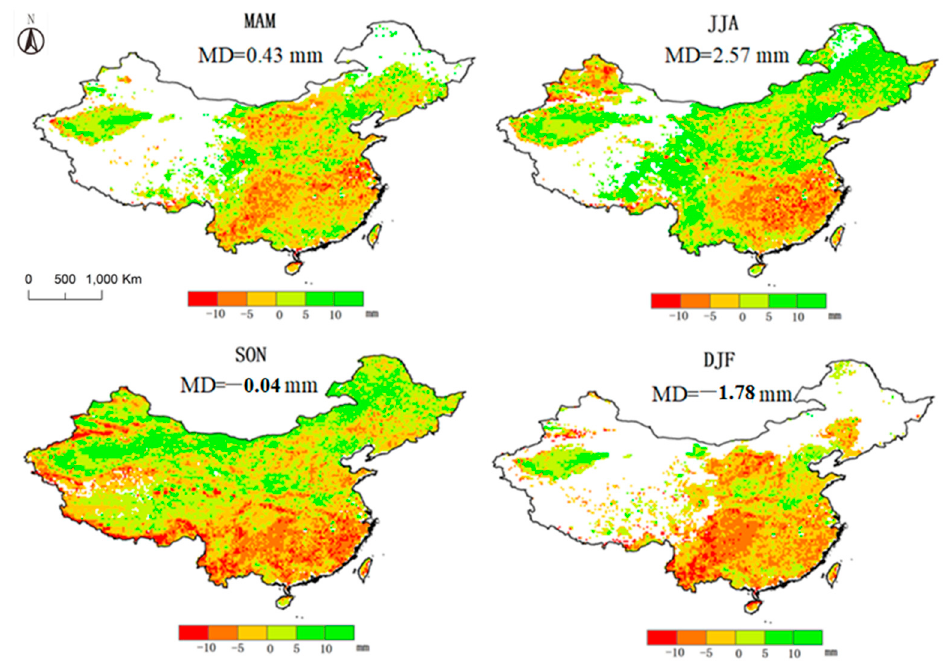
Figure 9. Comparisons of SM between simulations and the ESA-CCI cases for the 0–10 cm soil layer of seasonal differences (VIC minus ESA-CCI), from top to bottom for spring, summer, autumn, and winter. MD is the mean difference.